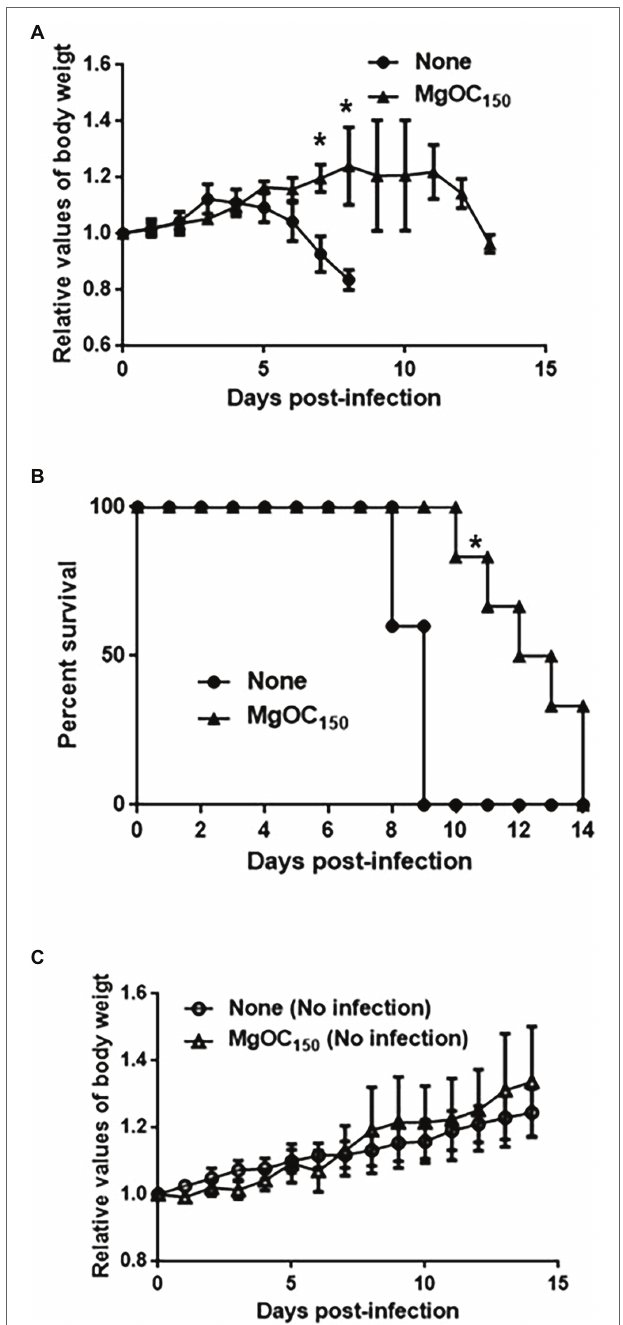
FIGURE 5 | Virulence of C. rodentium in C3H/HeJ mice after MgOC 150 administration. (A) Change in the body weight of C3H/HeJ mice infected with the DBS100 strain. The connecting lines denote the means, and the error bars denote the standard deviations. (B) Survival of C3H/HeJ mice infected with the DBS100 strain. (C) Change in the body weight of C3H/HeJ control mice. The connecting lines denote the means, and the error bars denote the standard deviations. Mice ( N = 5 mice bled without MgOC 150 for infection, N = 6 mice bled with MgOC 150 for infection, N = 5 control mice bled without MgOC 150 for non-infection, and N = 5 control mice bled with MgOC 150 for non-infection) were monitored daily. Asterisks denote the significances ( p < 0.05) of survival rate and body weight of mice administrated with MgOC 150 relative to those of mice administrated without MgOC 150